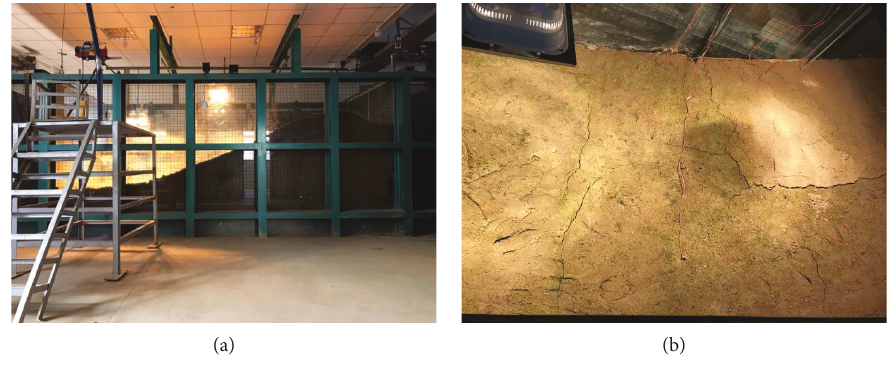
Figure 8: Simulated drought and crack